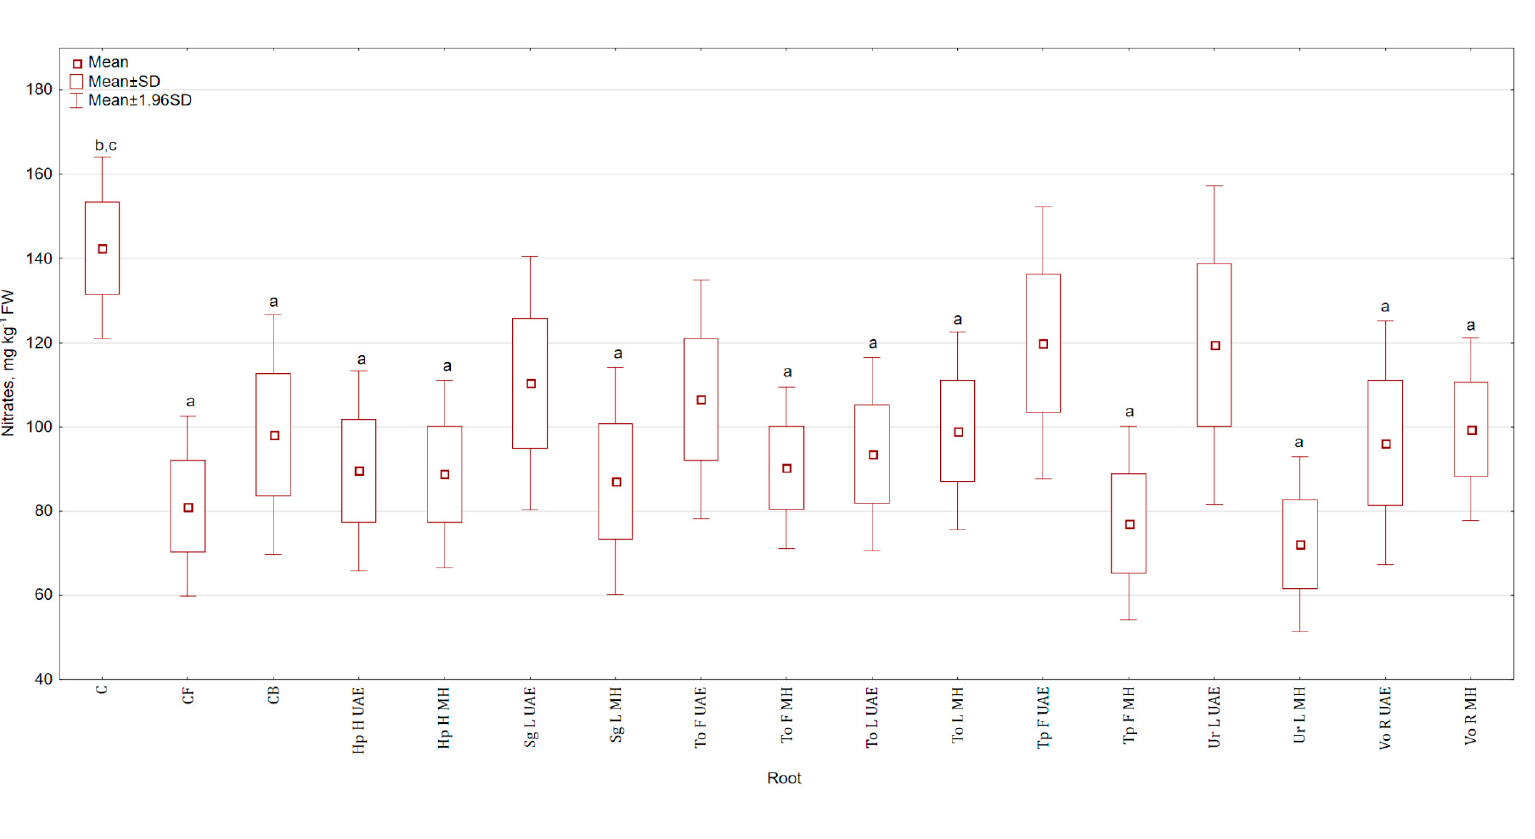
Figure 8. ( A ) Effect of the foliar application of botanical extracts on the nitrates content of celeriac leaves (N = 4). ( B ) Effect of the foliar application of botanical extracts on the nitrates content of celeriac roots (N = 4). (a) Statistically significant differences ( p < 0.05) between the control group (C) and extracts. (b) Statistically significant differences ( p < 0.05) between water formulation (CF) and extracts. (c) Statistically significant differences ( p < 0.05) between commercial biostimulant (CB) and extracts. 1st term of leaves rosette collection—samples taken for analyses 7 days after the second spraying. 2nd term of leaves rosette collection—samples taken for analyses after harvesting. Abbreviations: UAE, ultrasound assisted extraction; MH, mechanical homogenisation; Hp H, Hypericum perforatum L. (St. John’s wort, herb); Sg L, Solidago gigantea Ait. (giant goldenrod, leaf); To F, To L, Taraxacum officinale (L.) Weber ex F.H. Wigg (common dandelion, flower, leaf); Tp F, Trifolium pratense L. (red clover, flower); Ur L, Urtica dioica L. (nettle, leaf); Vo R, Valeriana officinalis L. (valerian, root).